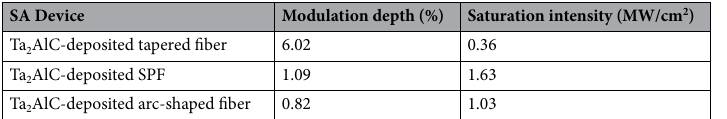
Table 1. Summary of the nonlinear properties of each of the SA devices.